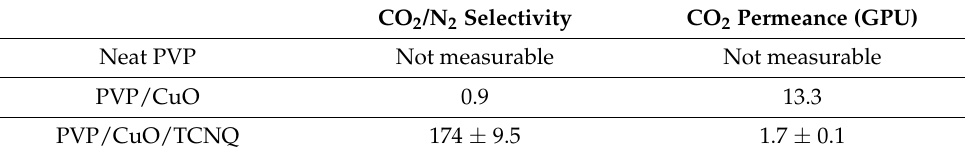
Table 1. Separation performance of neat PVP, PVP/CuO, and PVP/CuO/TCNQ composite membranes.